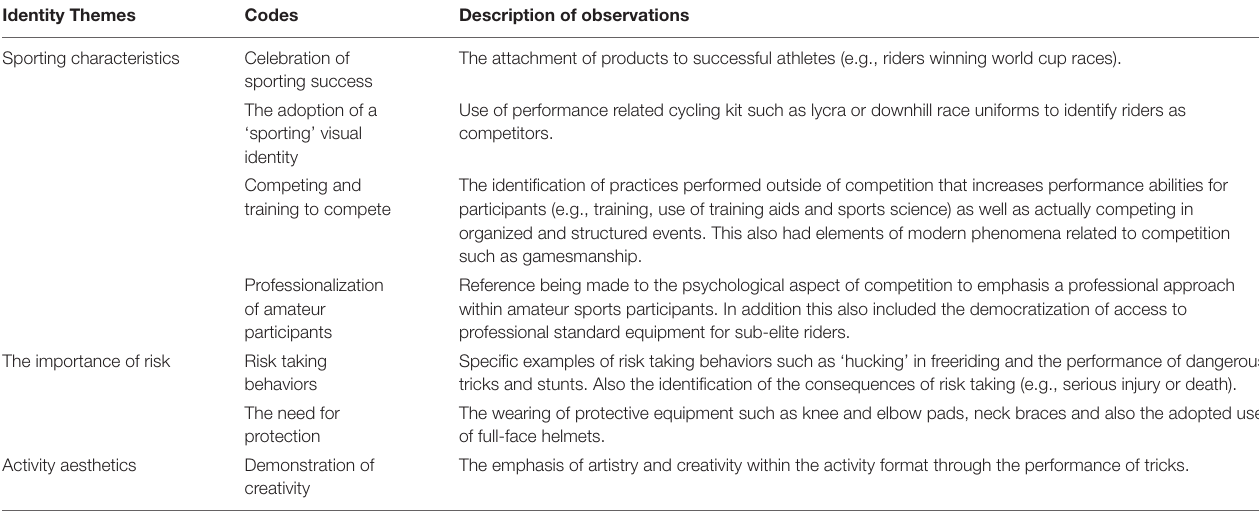
TABLE 2 | The three identity characteristic themes associated with mountain biking that were noted to varying between the various formats of the